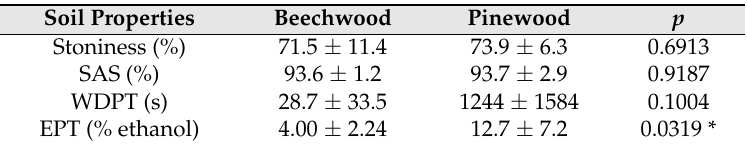
Table 2. Topsoil physical properties of Ah horizons (0–10 cm): stoniness, soil aggregate stability (SAS), water drop penetration time (WDPT), and ethanol percentage test (EPT). Values are expressed as mean ± standard deviation ( n = 5). p indicates p -value obtained from the one-way ANOVA test and significant differences ( p < 0.05) are marked with *.